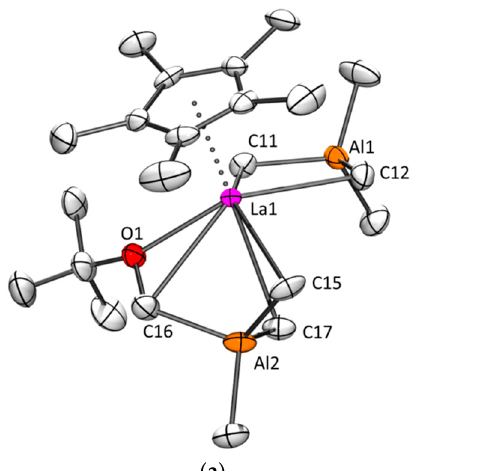
17 of 26 Figure 11. Connectivity overview of product 6 Gd , considered to be 24-membered macrocyclic compound